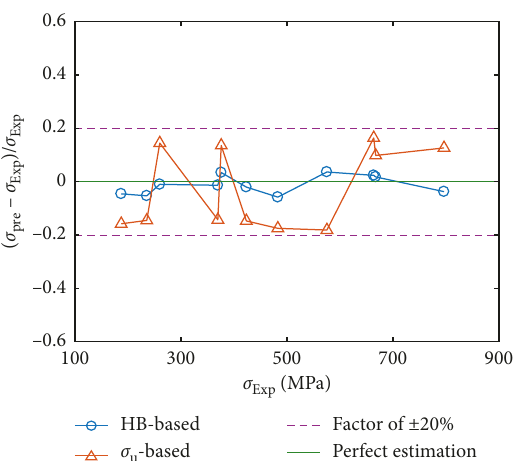
Figure 5: Schematic showing the limitation in comparing two different methods using scatter band